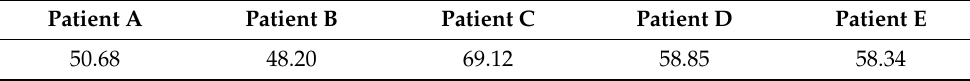
Table 1. The amount of collagen in the lesion (%).